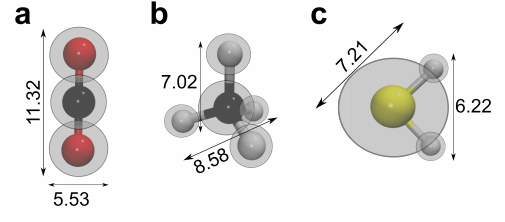
Figure 3. CO 2 ( a ), CH 4 ( b ) and H 2 S ( c ) molecules with their relative sizes in Å. Carbon atoms are shown in black, oxygens in red, hydrogens in white and sulfur in yellow. The dimensions are calculated considering their Van der Waals volumes, whose surfaces are represented as shaded